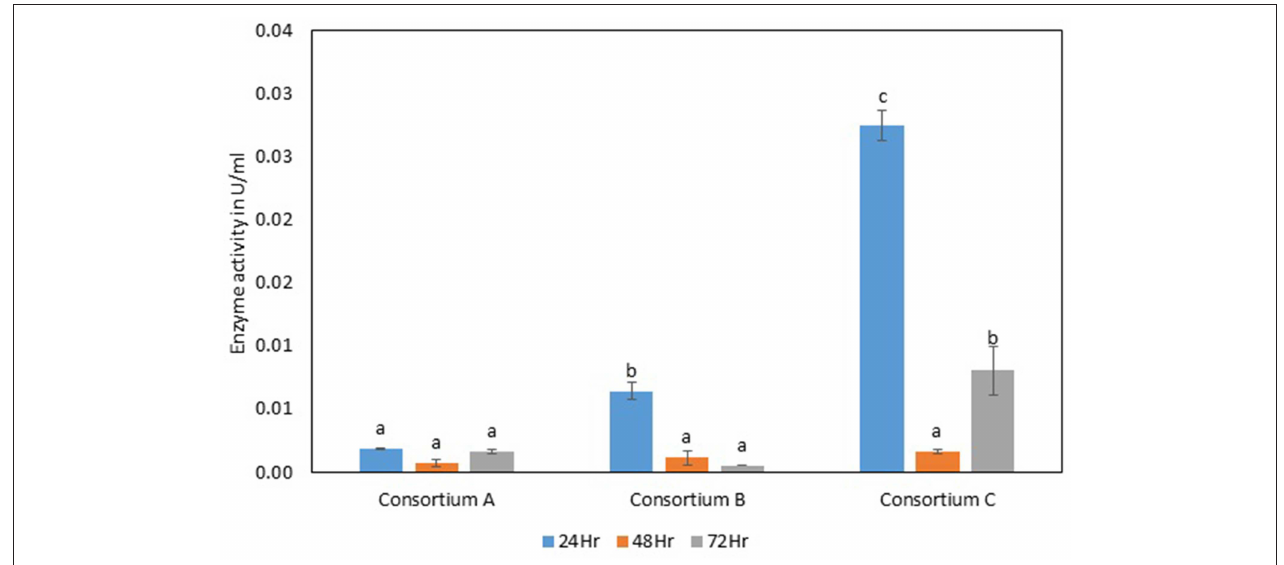
FIGURE 9 | Exoglucanase activity of different strains. Values are the mean ± SE (standard error). Mean values in each bar with the same alphabet superscript(s) do not differ significantly, but different alphabet superscript is showed significantly different between each treatment by Duncan post hoc test ( p ≤ 0.05).